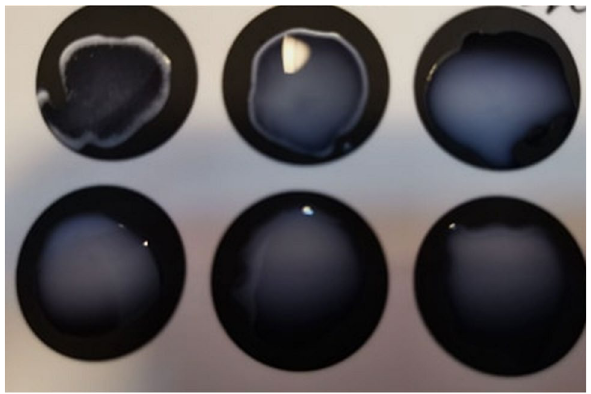
Figure 3. Aglutination reaction obtained using the LATEX-CRP detection kit at initial testing (T0).